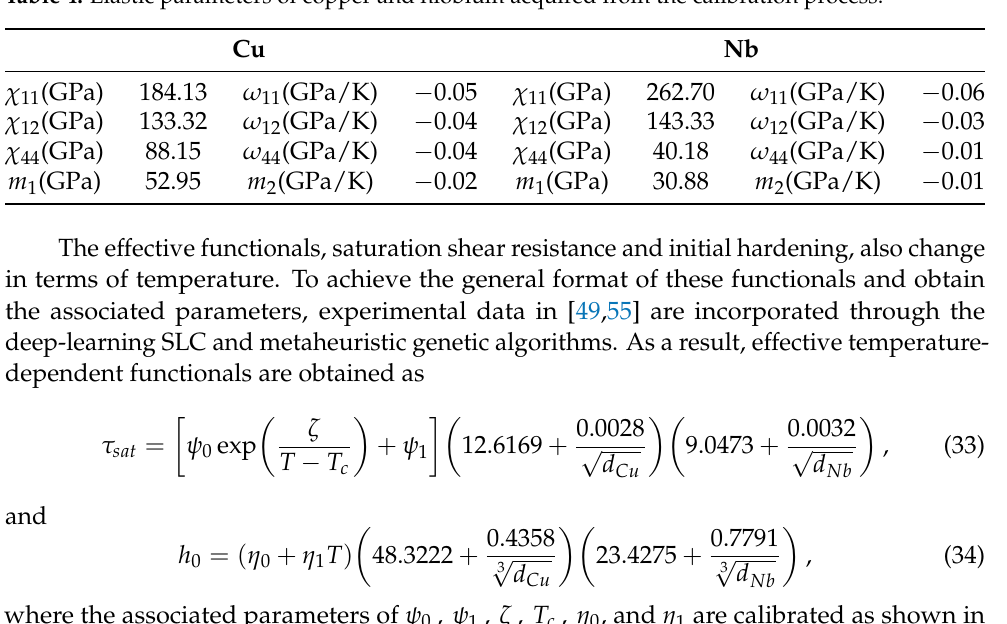
Table 4. Elastic parameters of copper and niobium acquired from the calibration process.